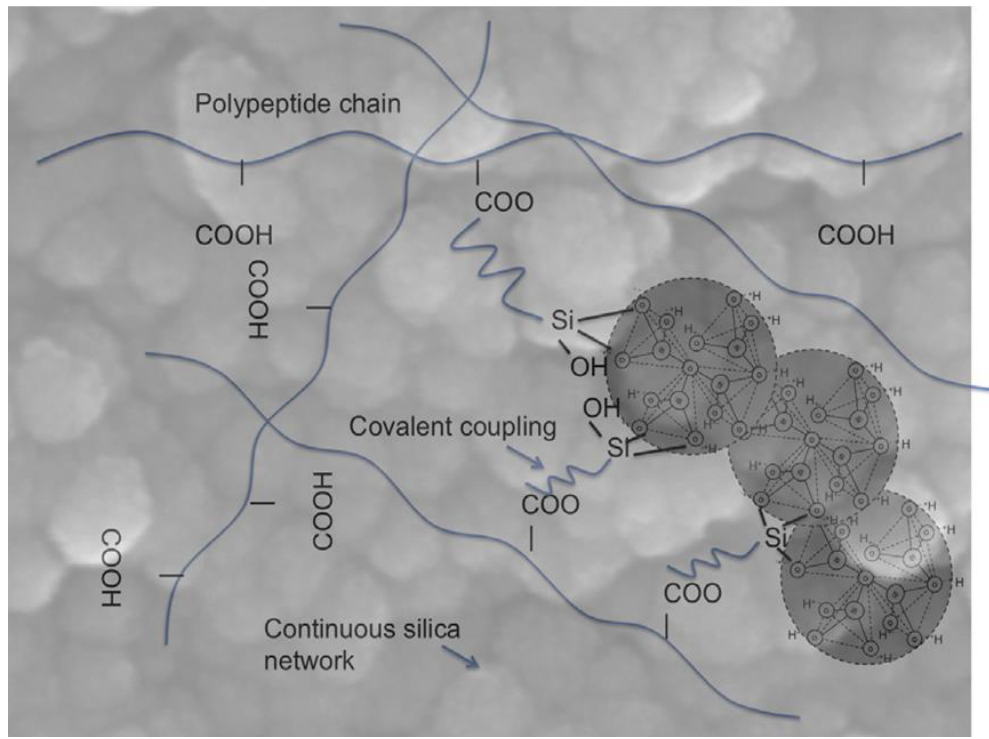
Figure 7. Schematic illustration of the interpenetrating inorganic and organic networks of a typical class-II hybrid material. Three nanoparticles of the continuous silica network are highlighted. The polymer chains are bonded to the silica network by a coupling agent (3-glycidyloxypropyl)trimethoxysilane (GPTMS)). Carboxylic acid groups on the polymer act as nucleophiles to open the epoxy ring of the GPTMS and form a bond. Image adapted from Jones [79] © Elsevier.